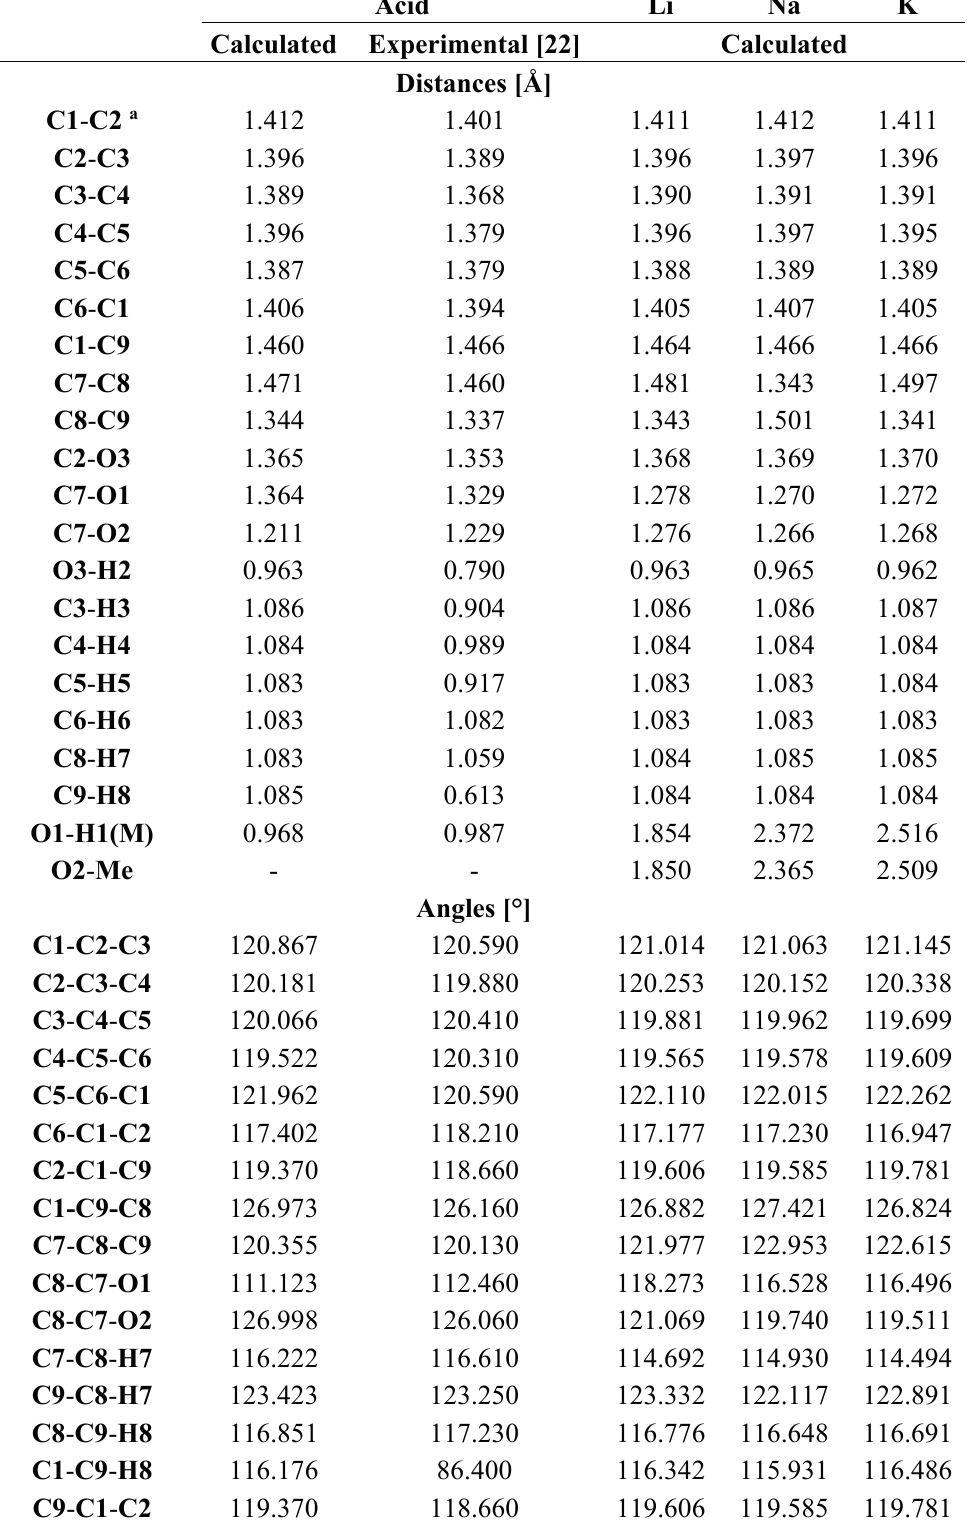
Table 1. Distances between atoms (Å), bonds angles (°) and geometric aromaticity indices calculated for trans o -coumaric acid and lithium, sodium and potassium o